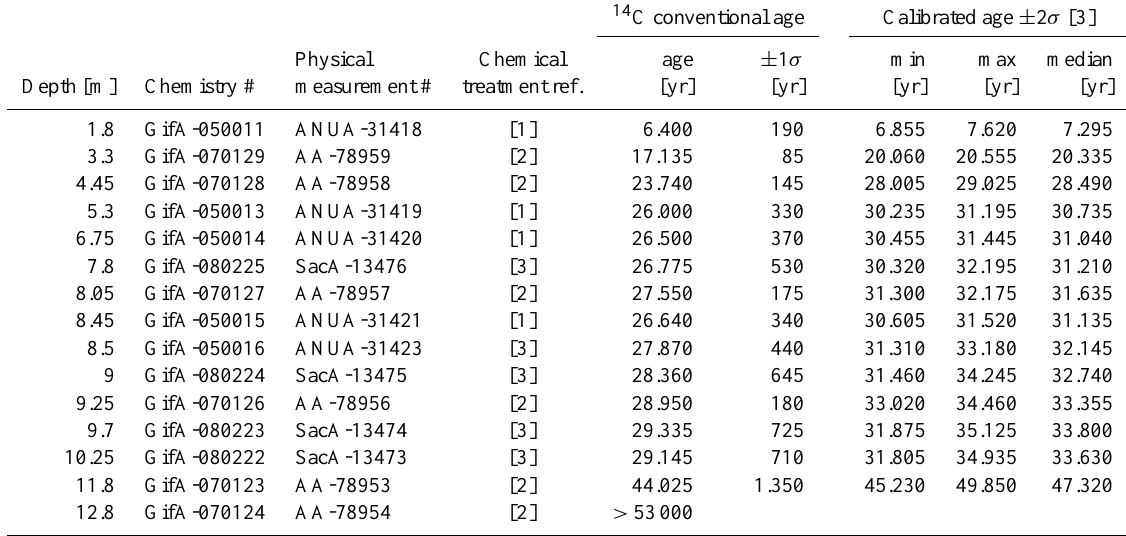
Table 2. Chronological data of the Surduk loess sequence: 14 C dating. The specificity of the chemical treatment prior to CO 2 evolvement and the 14 C activity measurement is provided in a reference column. The 14 C results are shown as conventional 14 C and calibrated 14 C ages based on the Calib 6.0 calibration (Reimer et al., 2009), for which minimum, maximum and median ages are given. 14 C conventional